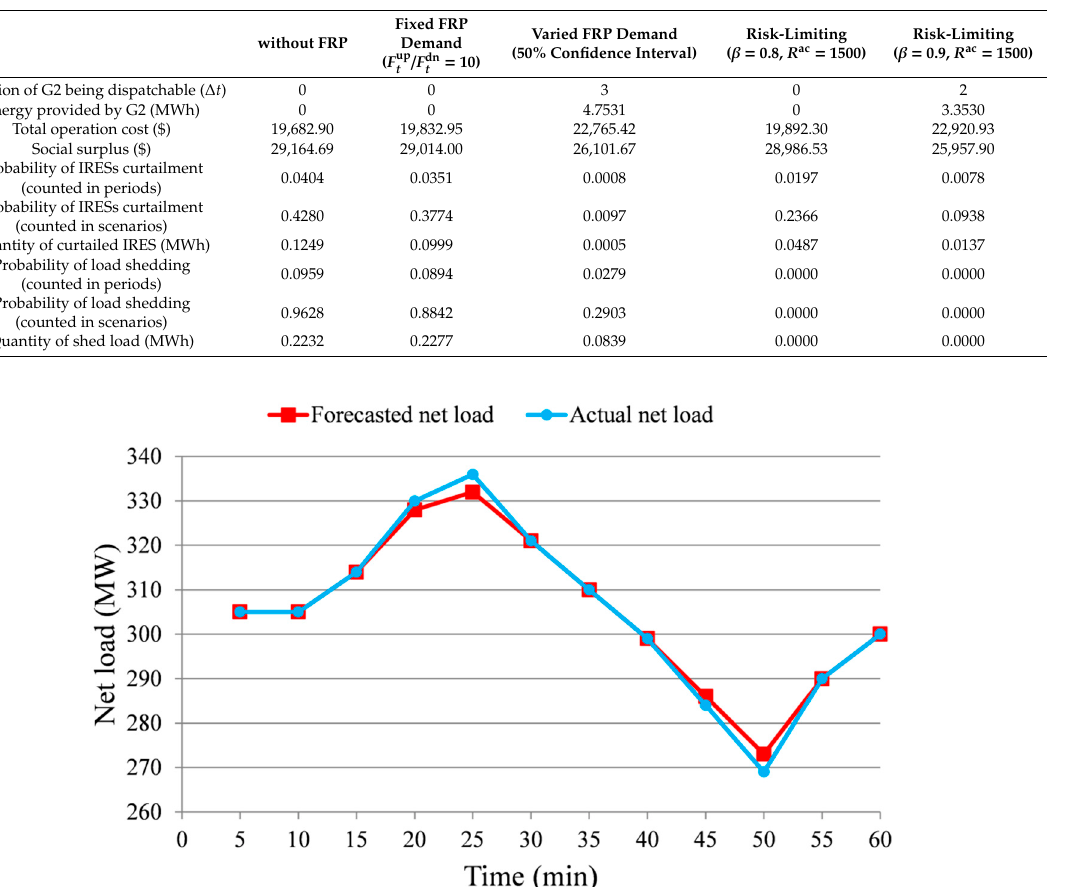
Table 3. Simulation results with and without flexible ramping products (FRP).